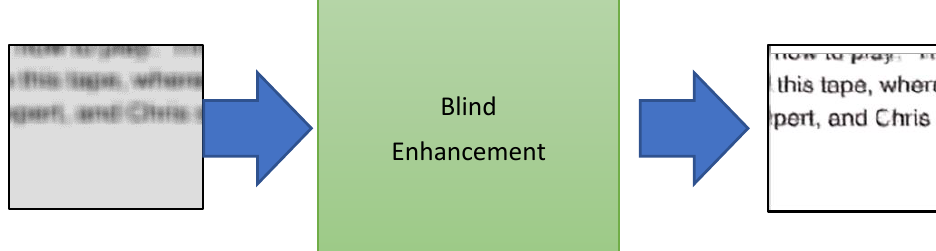
Figure 1. Blind blur enhancement: The input image contains different kinds of distortions such as blur, noise, contrast issues, and shadows. The blind enhancement model should remove the distortions (e.g., blur) and produce a clean document image.